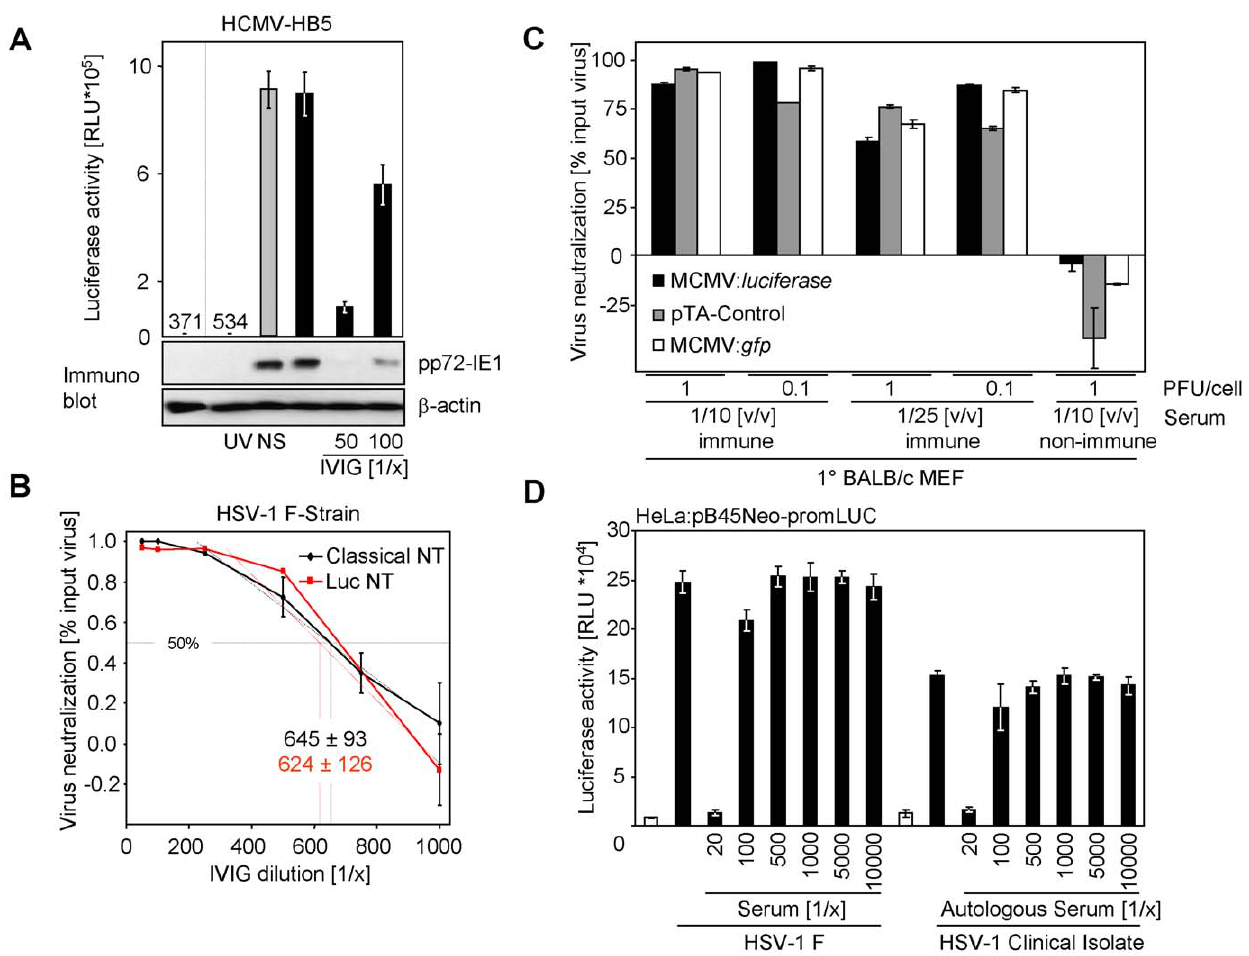
Figure 8. Comparison of new test principle with established methodology. ( A ) MRC-5 cells were transiently transfected (Lipofectamine) with pTA-Control plasmid. Cells were split and seeded before mock-infection or infection with UV-inactivated HCMV-HB5 or HCMV-HB5. Virus had been incubated with a 1/50 dilution of negative human serum (NS; grey bar), no serum or with the indicated dilutions of the IVIG preparation Cytotect H (black bars) for 1 h at 37 u C. 20 h p. i. cells were lysed and luciferase activity was measured. An aliquot of the same lysates was separated by sodium-dodecylsulfate-PAGE. The proteins were transferred on filters and probed with pp72-IE1 and b -actin specific antibodies. ( B ) Comparison of the newly established luciferase-based neutralization test with a classical neutralization test. For the classical neutralization test, serial dilutions of Cytotect H were incubated for 1.5 h with 2 PFU/cell of the HSV-1 strain F prior to infection of CV-1 cells. 36 h p.i. plaques were counted. The mean of quadruplet values 6 SD is shown. For the luciferase-based NT CV-1 cells were transiently transfected (Lipofectamine 2000 CD) with pTA-control plasmid, split and seeded. 2 PFU/cell of the HSV-1 strain F were incubated for 1.5 h with serially diluted Cytotect H before infecting CV-1 cells. 20 h p. i. the cells were lysed and luciferase activity was measured. The neutralization titer is determined as serum dilution able to mediate 50% virus neutralization. ( C ) Primary embryonic mouse fibroblasts were transfected by nucleofection with pTA-Control plasmid or left untransfected. wt-MCMV Smith strain, MCMV: gfp or D m157-MCMV: luciferase were incubated for 90 min at 37 u C with 1/10 (v/v) or 1/25 (v/v) dilutions of mouse (BALB/c) MCMV-immune serum or the control non-immune serum. Cells were infected with these suspensions. 16 h later cells were lysed for the determination of luciferase activity in the case of untransfected cells infected with D m157-MCMV: luciferase and the pTA-Control transfected cells infected with wt-MCMV. GFP-positive cells were determined by FACS for MCMV- gfp . The relative neutralization of the input virus is depicted. ( D ) 5 PFU/cell HSV-1 F strain or a low-passage clinical HSV-1 isolate were incubated for 90 min at 37 u C with indicated dilutions of the autologous human serum derived from the individual the virus was isolated from. 16 h later cells were lysed and luciferase was determined.